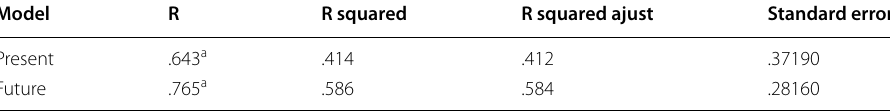
a Predictors: (Constant). Cover